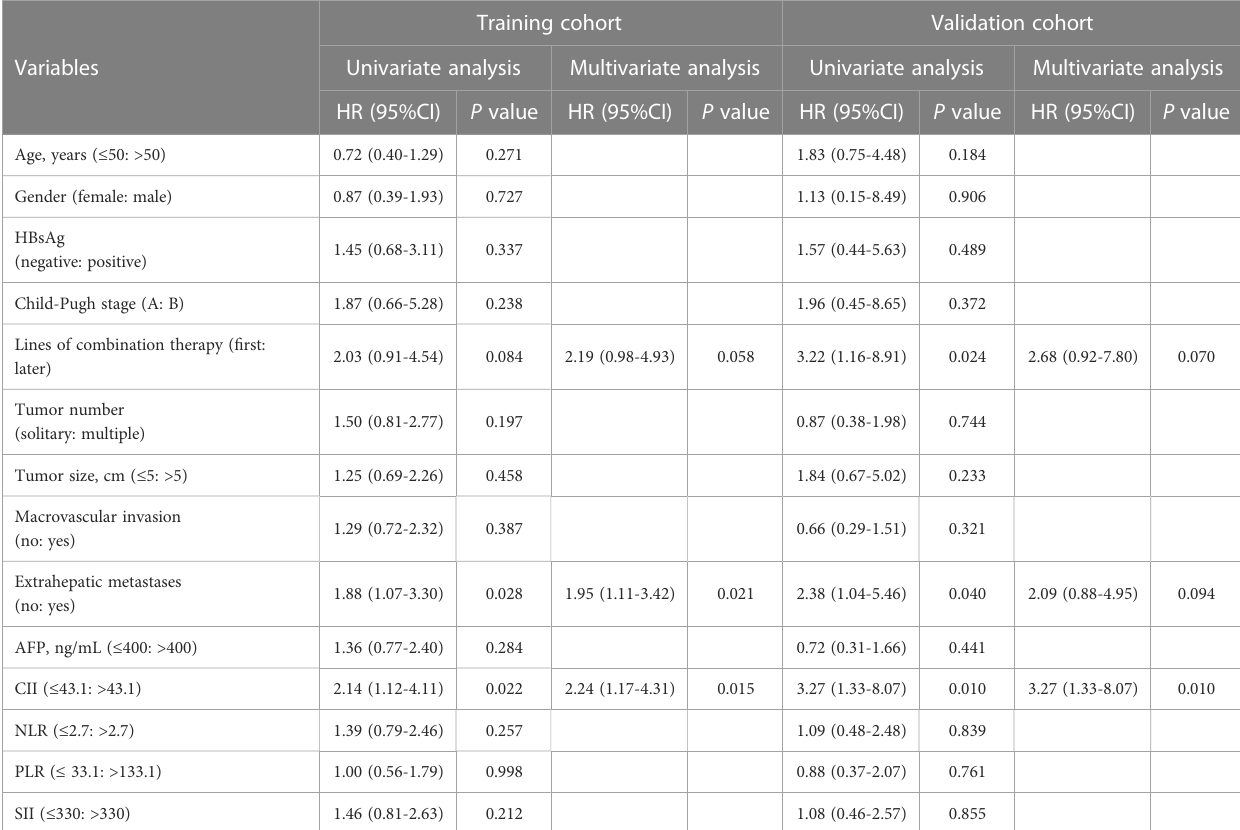
TABLE 2 Univariate and multivariate analyses for overall survival in the training cohort and validation cohort.